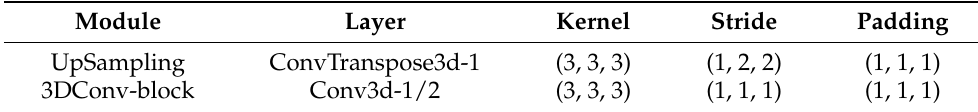
Table 3. Architecture of 3D convolution in module (c).